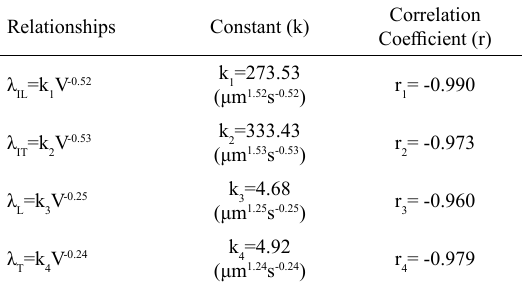
Table 2. The relationships between the microstructure parameters and the solidification rate